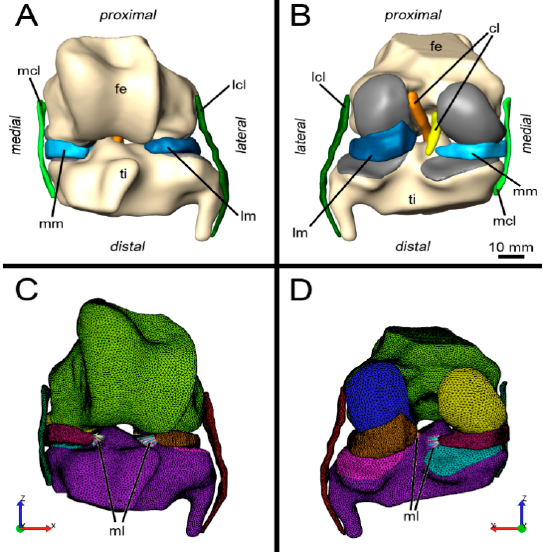
Figure 1. Overview of the equine stifle 3D model used for finite element analysis (FEA). ( A ) Cranial view of the 3D model of the horse stifle joint. Polygon triangle meshes were generated from image segmentation based on MRI data using the commercial 3D software package Amira 5.3. ( B ) Caudal view of the 3D model of the horse stifle joint. ( C ) Cranial view showing elements of the finite element model generated using the software package Preview of the FEBio Software Suite. Meniscal ligaments were simulated as spring tied interface contacts. ( D ) Caudal view of the elements of the finite element